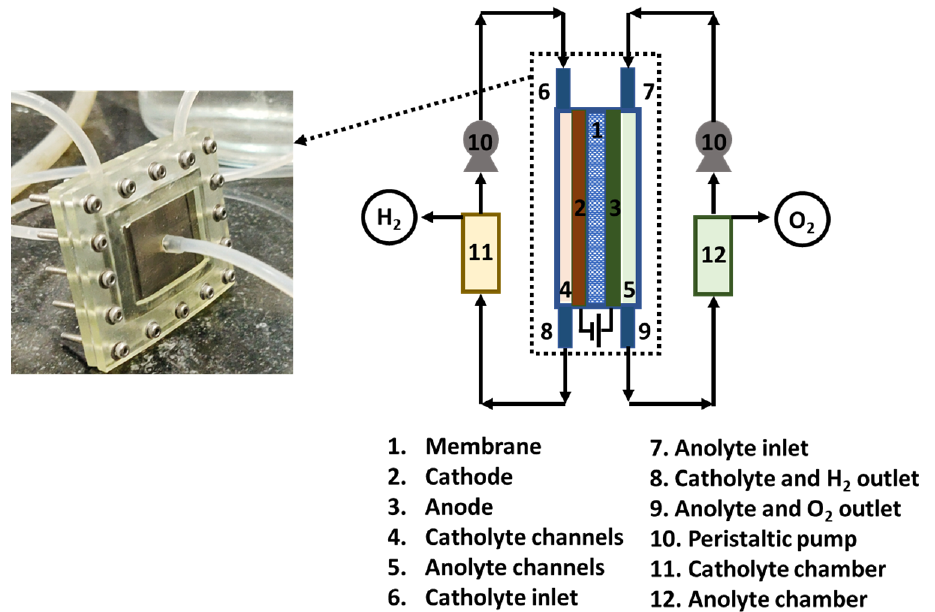
Figure 1. Schematic representation of the experimental setup to evaluate the performance of lignin electrolysis and water electrolysis.